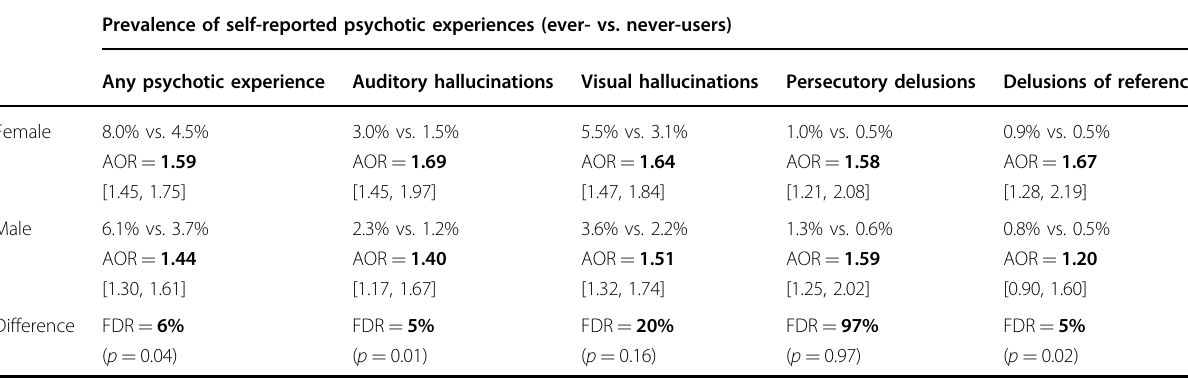
Table 3 Sex differences in associations between psychotic experiences and cannabis ever-use.